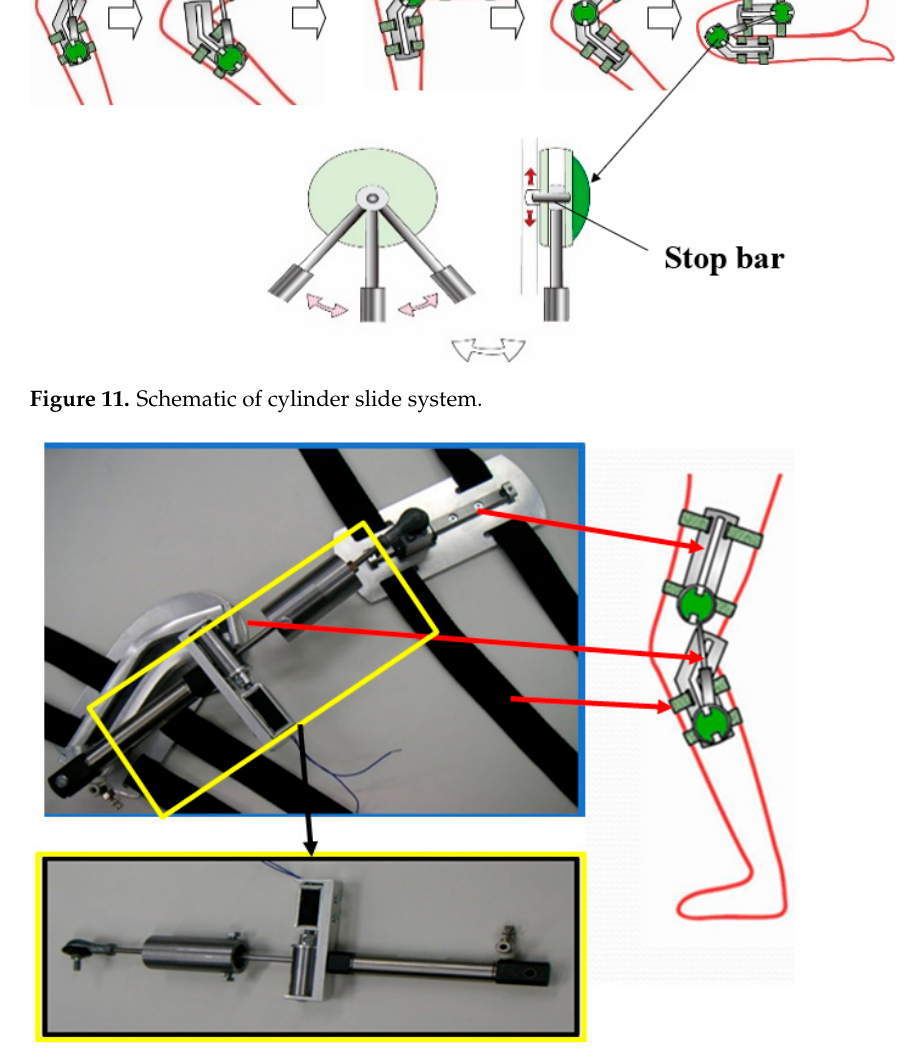
Figure 12. The prototype developed for this Figure 12 . The prototype developed for this project.